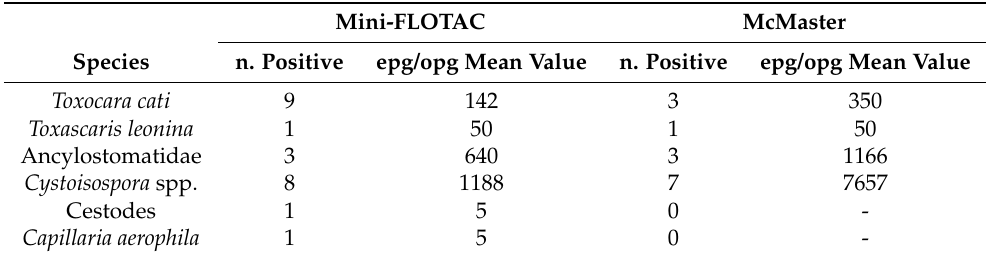
Table 8. Number (n) of feline positive samples detected using quantitative techniques and mean value of epg (eggs per gram of feces) or opg (oocysts per gram of feces) retrieved for each parasite.